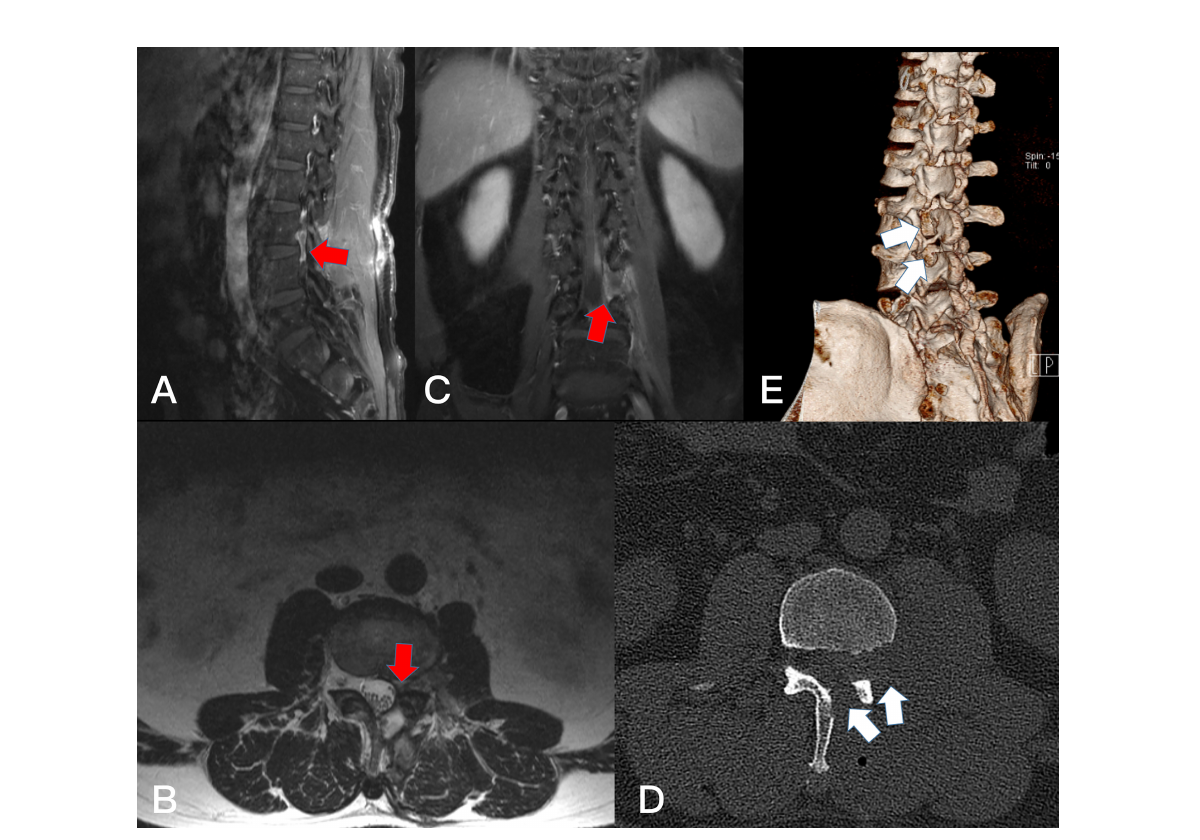
FIGURE 5 Postoperative T2-weighted MRI on sagittal (A) , axial (B) , and T1-weighted enhanced on coronal (C) plane, Resection of the dumbbell tumor could not be identi fi edafter 6 months (red arrows). The axial plane and 3D-CT scan showed the bone window of L3 and L4 lamina (D, E) (white